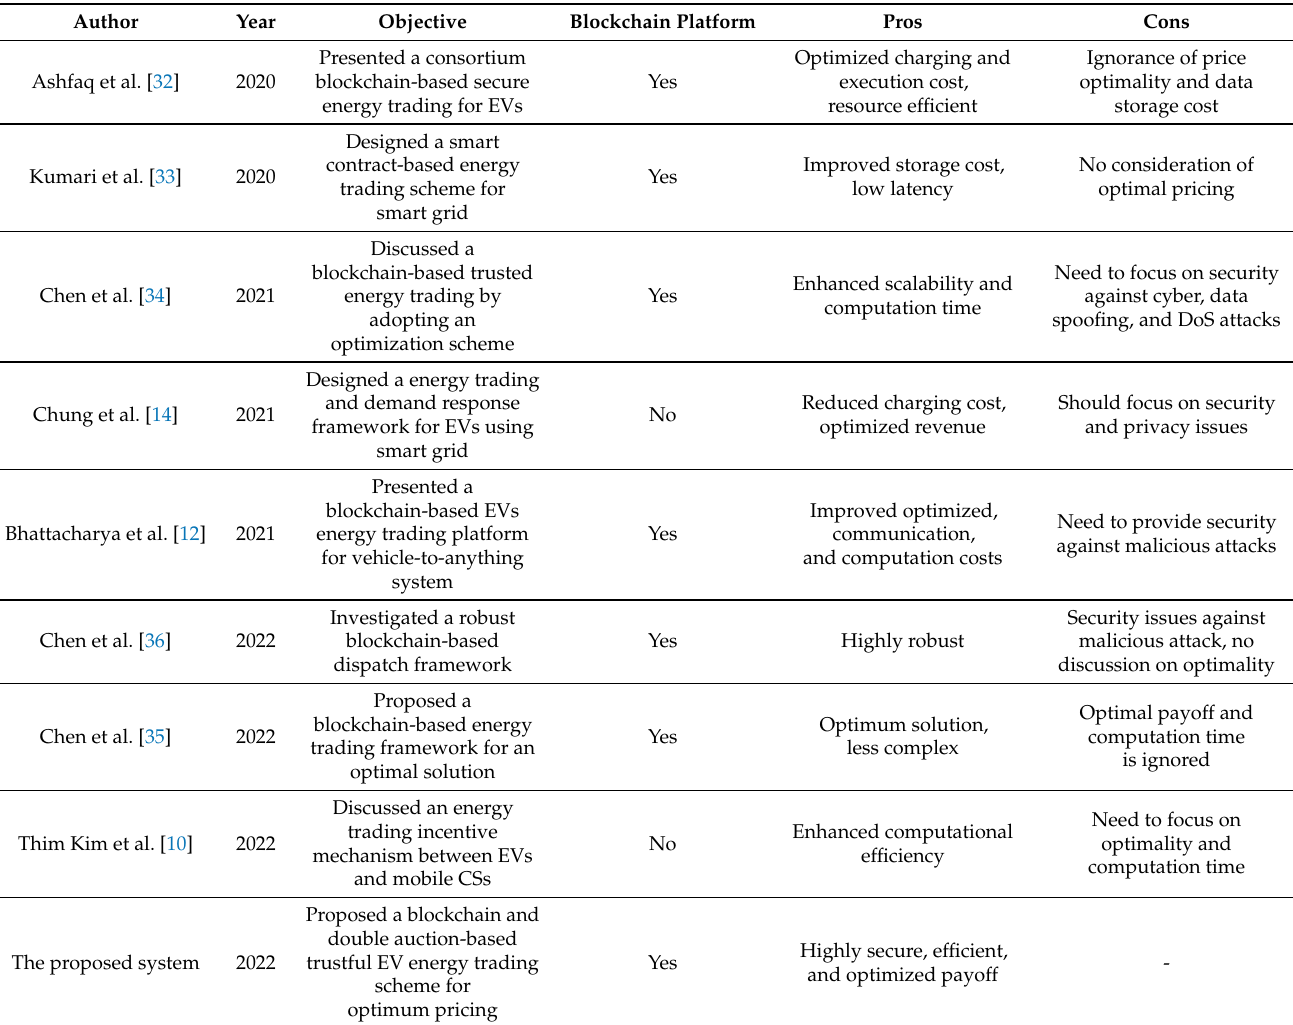
Table 1. Comparative analysis of various state-of-the-art energy trading schemes with the pro- posed